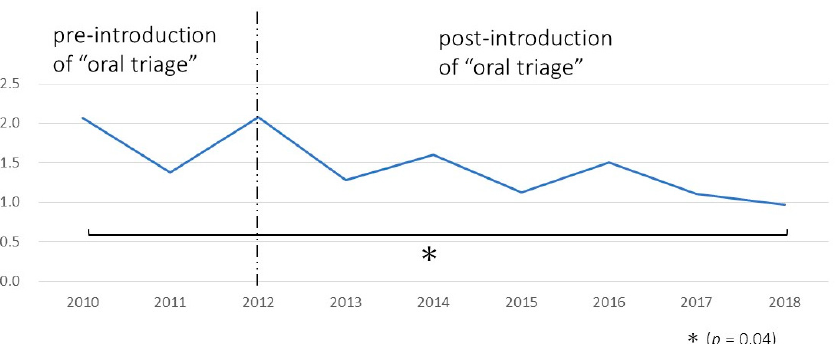
Figure 5. Changes in the incidence rate of postoperative pneumonia in the target group. The inci- dence rate was significantly reduced in 2018, after the introduction.